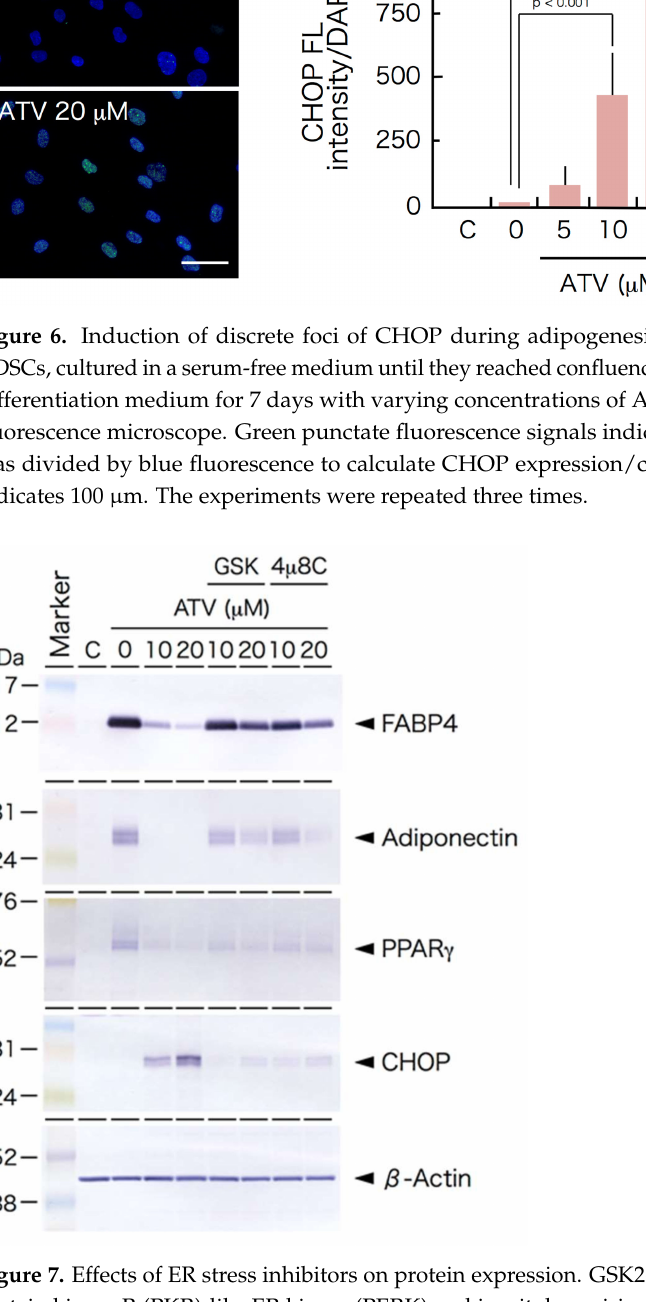
Figure 7. Effects of ER stress inhibitors on protein expression. GSK2606414 and 4 µ 8C, which inhibit protein kinase R (PKR)-like ER kinase (PERK) and inositol requiring enzyme 1 (IRE-1), respectively, were dissolved in DMSO at 20 mM and stored at − 30 ◦ C until usage. The final concentration was 40 µ M for GSK2606414 and 20 µ M for 4 µ 8C, and they were added concurrently with ATV when medium was changed to differentiation medium. Cells were treated with ATV and inhibitor for 10 days before protein extraction. Protein samples (8 or 16 µ g) were electrophoresed on SDS- polyacrylamide gel, electrophoretically transferred to a polyvinyl difluoride membrane, and the membrane was incubated with the indicated primary